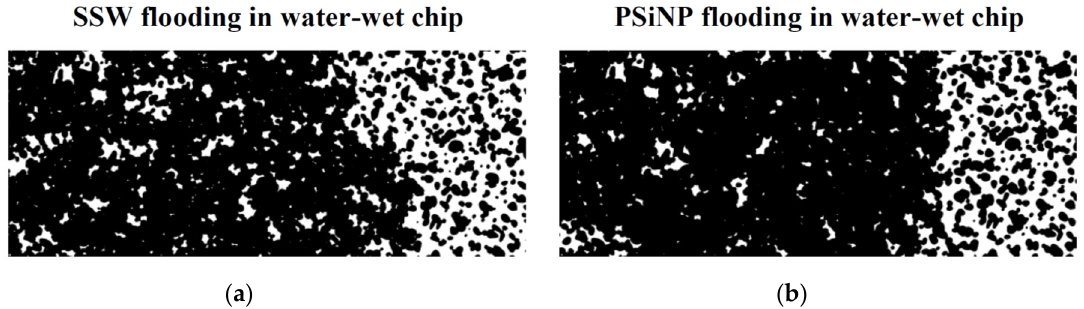
Figure 8. Results for PSiNPs flooding at different wettability states with 0.1 µL/min. Dynamic change in ( a ) oil connectivity as a function of pore volumes injected, and ( b ) the residual oil cluster size distribution.